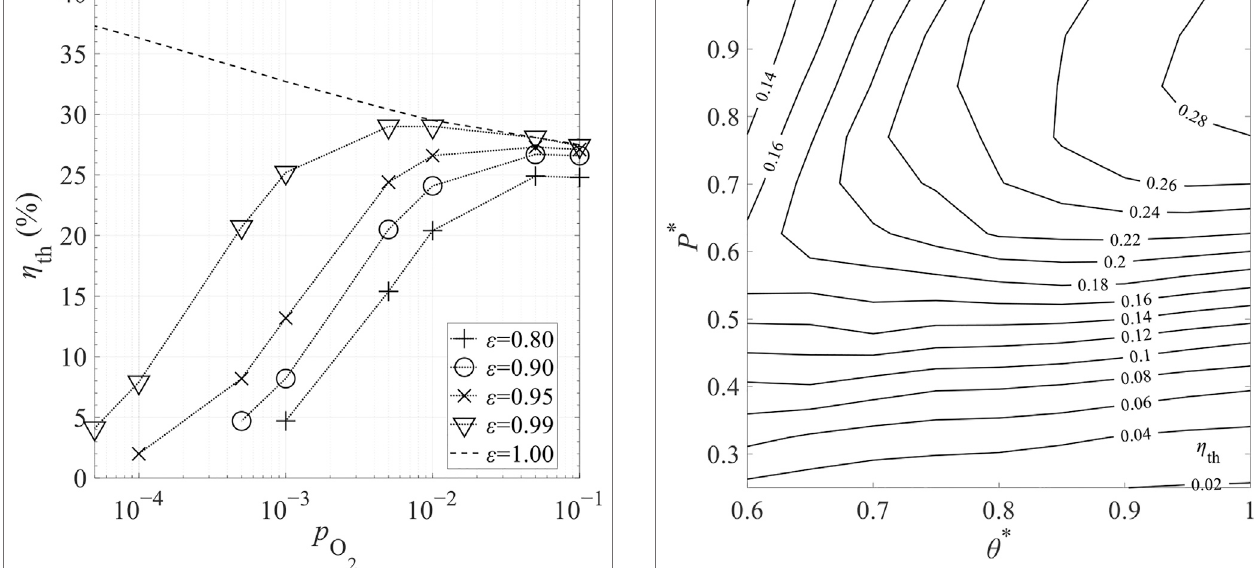
FIGURE 18 | Effect of gas-phase heat transfer effectiveness, ε , on total solar-to-fuel ef fi ciency η th in different levels of relative oxygen partial pressure, p O , with a concentration ratio C of 3,000 at T red (cid:2) 1,900 K. The top dashed 2 line shows the limit of η th for perfect gas-phase heat exchange.